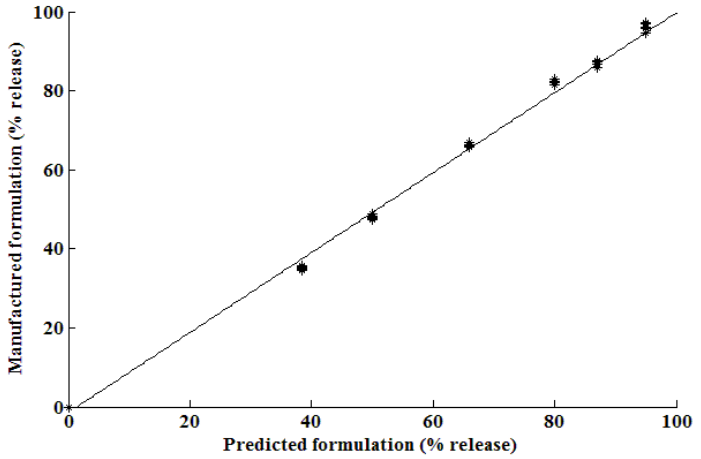
Figure 7. Percent drug release for the optimized vs. predicted formulation with y = x – 2.5 and R 2 =